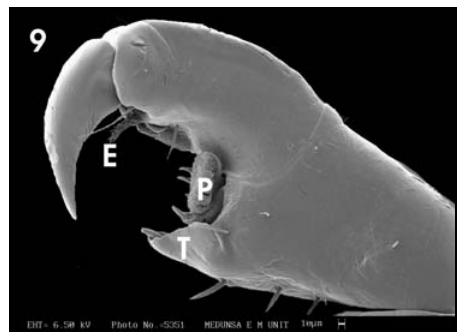
Fig. 9. The claw with the distiotibial thumb (T), dis- tiotibial pad (P) and empodium (E).